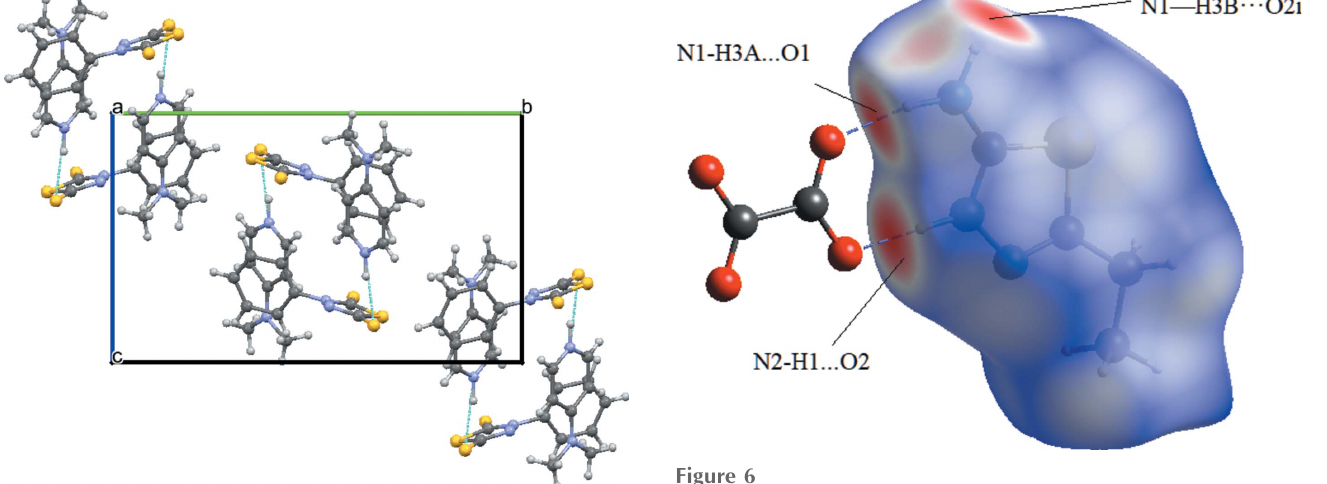
Figure 5 Packing diagram of compound (II) viewed down the a -axis. The hydrogen bonds are shown as dashed lines.